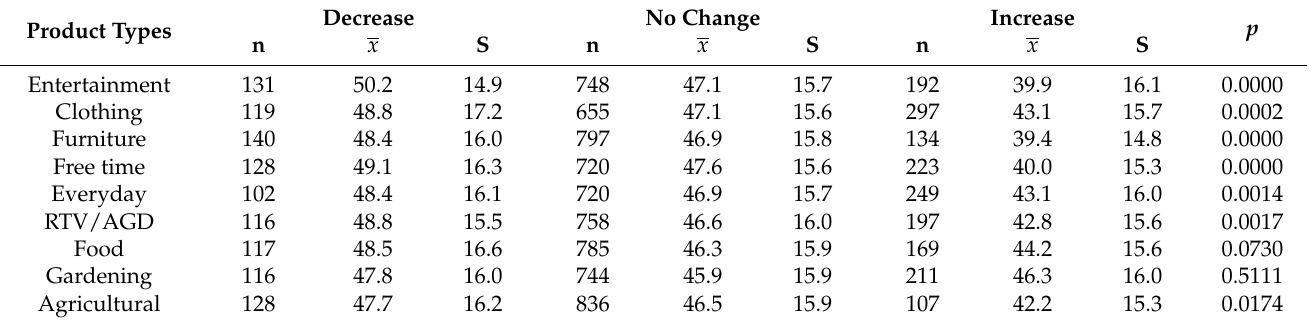
Table 6. Relation between the age of rural e-customers and the frequency of online purchases before and during the COVID-19 pandemic (own